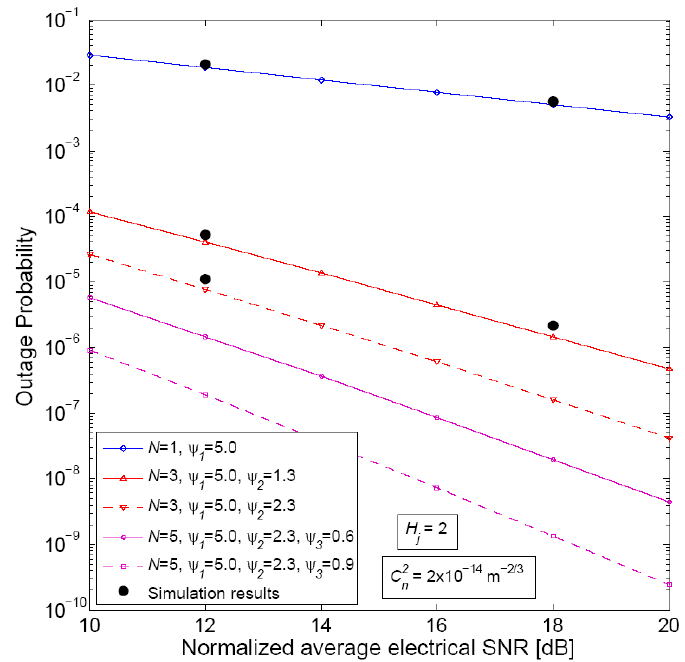
Figure 4. Total outage probability (OP) of a dual-hop relay-aided system with varying path configurations as a function of a wide range of γ / µ , for gamma-gamma (G-G) modeled weak turbulent channels, along with different amounts of pointing mismatch.